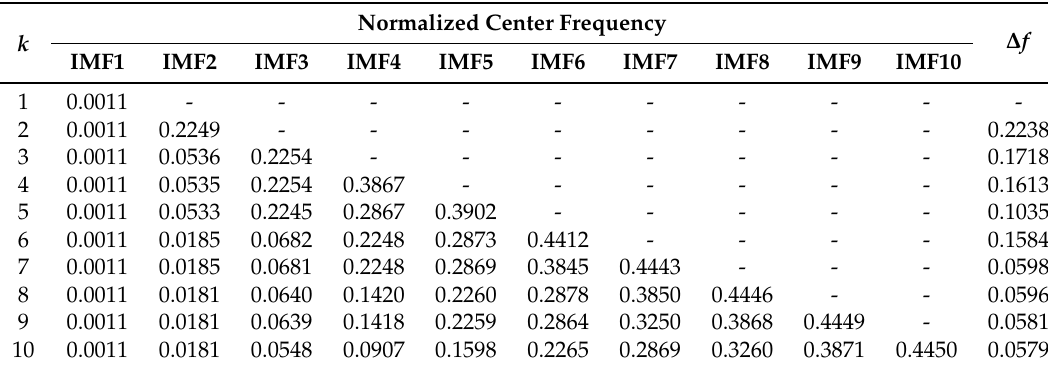
Table 1. Center frequency corresponding to different mode number, k